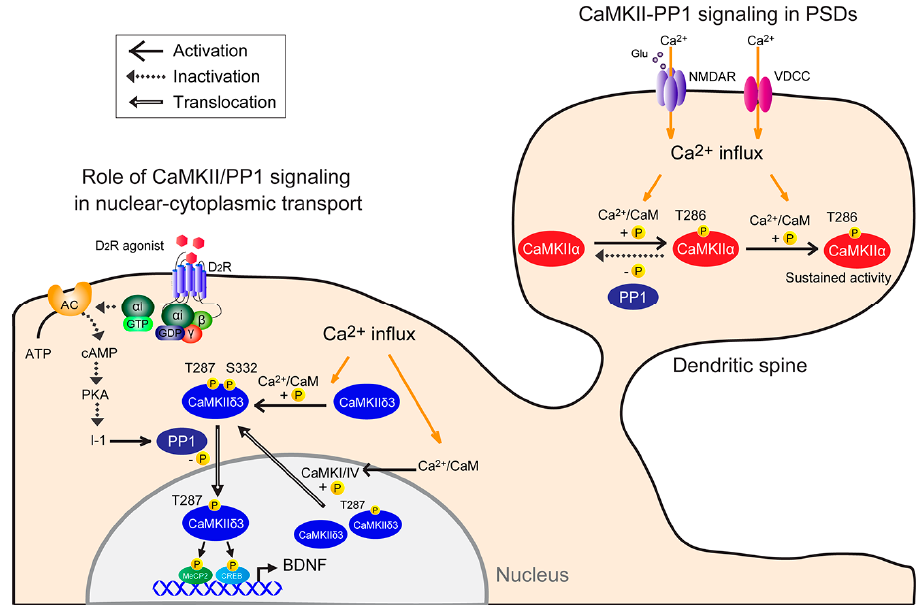
Figure 1. Model of neuronal CaMKII-PP1 signaling. (1) CaMKII-PP1 signaling in PSDs: CaMKII is simultaneously bound by Ca 2+ /CaM following a Ca 2+ stimulus. In this condition, one subunit acts as a substrate for the other, resulting in Thr286 phosphorylation. Once that subunit is phosphorylated, subsequent phosphorylation within the holoenzyme is more likely to occur, as Ca 2+ levels required for the second phosphorylation are lower than those required for the initial phosphorylation (sustained activity). Thus, CaMKII remains active, even when basal Ca 2+ levels are re-established, until it is dephosphorylated by PP1. CaMKII activity is sustained if the number of phosphorylated subunits exceeds a threshold and the phosphorylation rate exceeds the dephosphorylation rate. (2) Role of CaMKII/PP1 signaling in nuclear-cytoplasmic transport: Under basal conditions, CaMKII δ 3 is autonomously active in part due to spontaneous neuronal activity. Cytoplasmic CaMKII δ 3 is autophosphorylated, and D2R-mediated PP1 activation mediates CaMKII δ 3 dephosphorylation at Ser332. For example, stimulation with a dopamine D2R agonist increases PP1 activity by inactivating the cAMP/PKA/inhibitor 1 (I-1) pathway, and in turn PP1 dephosphorylates CaMKII δ 3 at Ser332 in the cytoplasm, enabling its nuclear translocation. Thereafter, nuclear CaMKII3 phosphorylates transcription factors, including MeCP2 and CREB, increasing BDNF expression. Depolarization causes Ca 2+ entry into neurons through NMDA receptors or voltage-dependent calcium channels and promotes CaMKII δ 3 autophosphorylation at Thr287 and Ser332 in the cytosol. Conversely, nuclear CaMKI or CaMKIV activity may promote CaMKII δ 3 nuclear export via Ser332 phosphorylation.